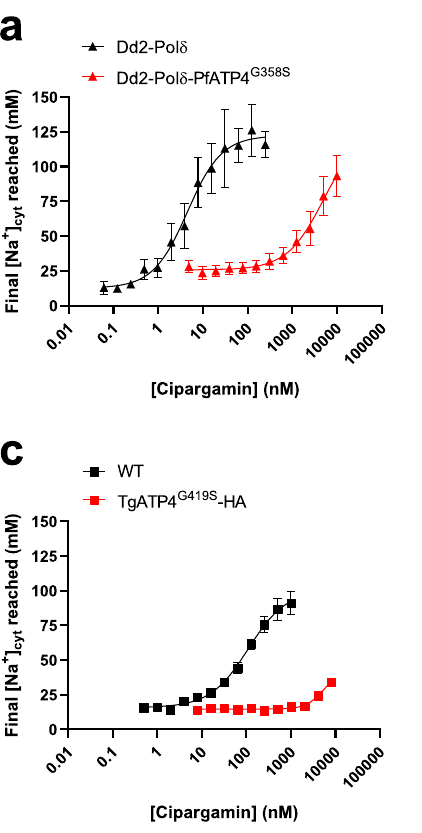
Fig. 3 | Parasites with the G358S mutation in PfATP4 or the G419S mutation in TgATP4areresistanttocipargamin-and(+)-SJ733-mediatedNa + dysregulation. The fi nal [Na + ] cyt reached after a ~90min exposure to a range of concentrations of cipargamin( a , c )or(+)-SJ733( b , d ).Themeasurementswereperformed at 37°Cin pH7.1PhysiologicalSalineSolutionwithisolated SBFI-loadedDd2-Pol δ (black)and Dd2-Pol δ -PfATP4 G358S (red) P. falciparum trophozoites (triangles; a , b ) and with extracellular SBFI-loaded T.gondii tachyzoites(squares; c , d )expressingTgATP4 WT (black) or TgATP4 G419S -HA (red). The data are the mean(± SEM) from the following